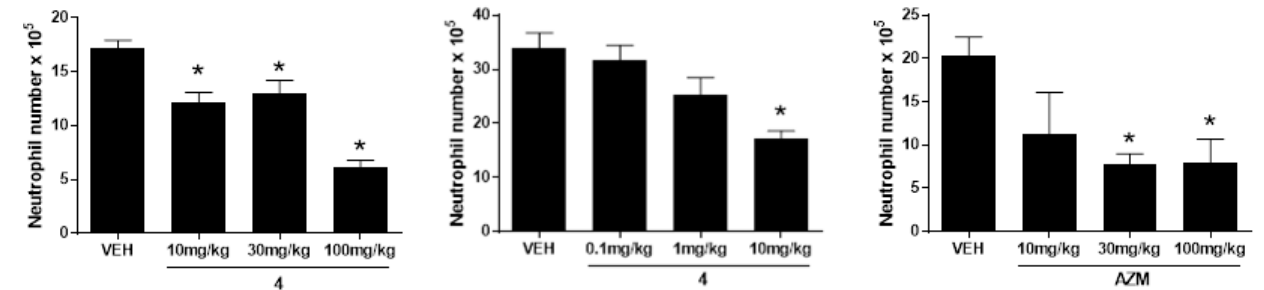
Figure 4. Neutrophil number in BALF 24 h after cigarette-smoke challenge. Compound 4 or azithromycin (AZM) were administered orally 2 h prior smoke challenge on each smoke day. Data are presented as means ± S.E.M. of 5 animals per group. The asterisk represents p < 0.05, one-way ANOVA followed by Dunnett’s multiple comparison test.